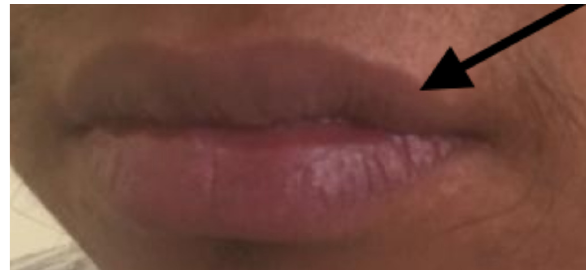
Image 2. Mild cyanosis of lips (arrow) demonstrating chronic hypoxemia.